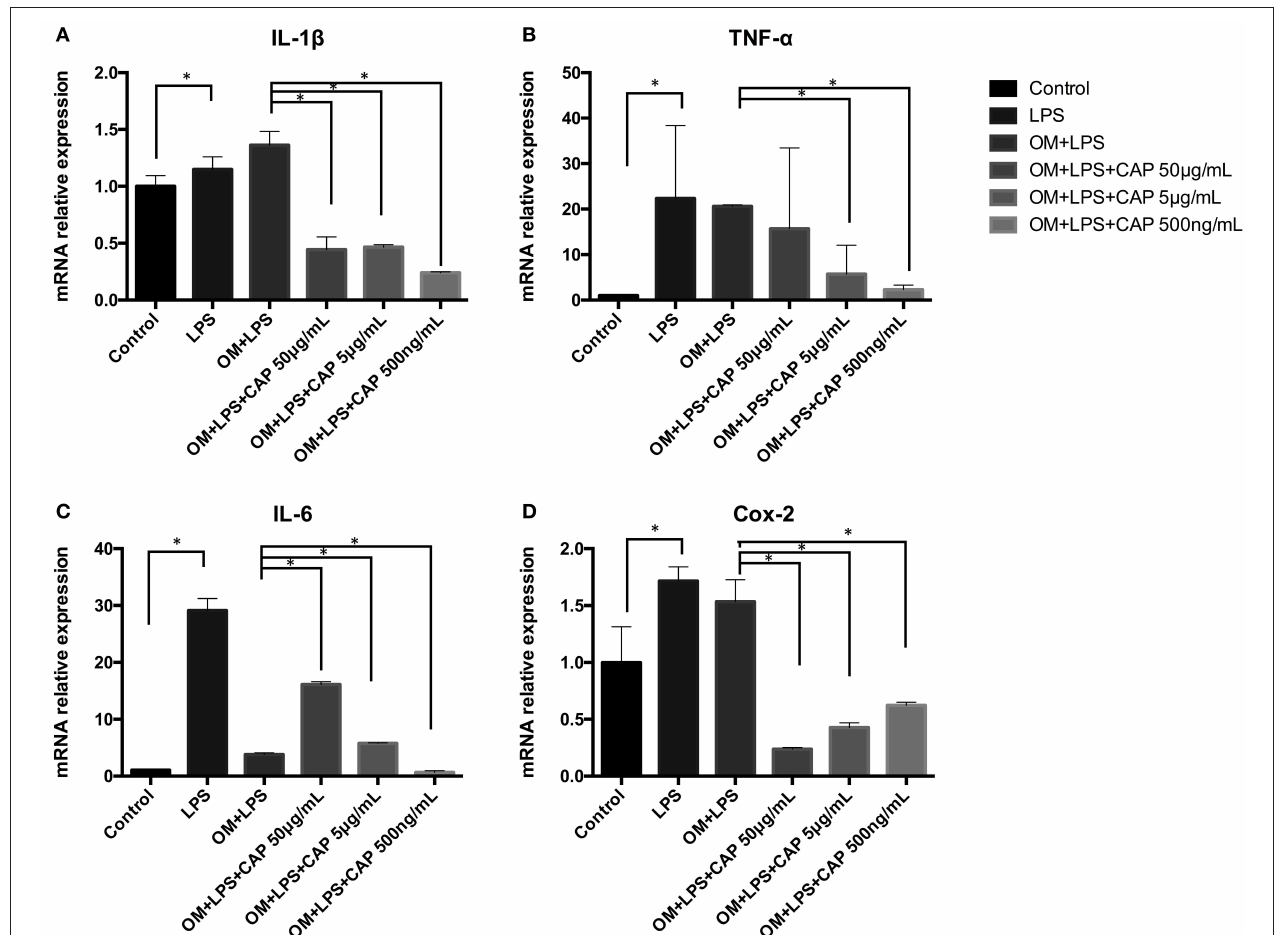
FIGURE 3 | Quantitative PCR analysis results for the inflammatory cytokines IL-1 β (A) , TNF- α (B) , IL-6 (C) , and COX-2 (D) upon treatment with CL. The asterisks indicate significant differences between groups (* p ≤ 0.05 one-way ANOVA and LSD comparison test) and the bars represent the standard deviation of three